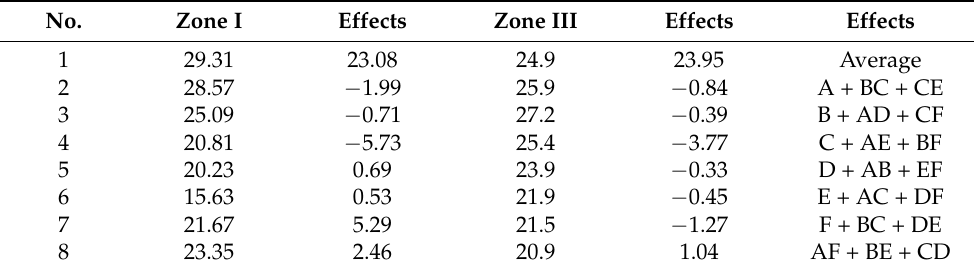
Table 7. Average values and standardised effects on the volume fraction of carbides.